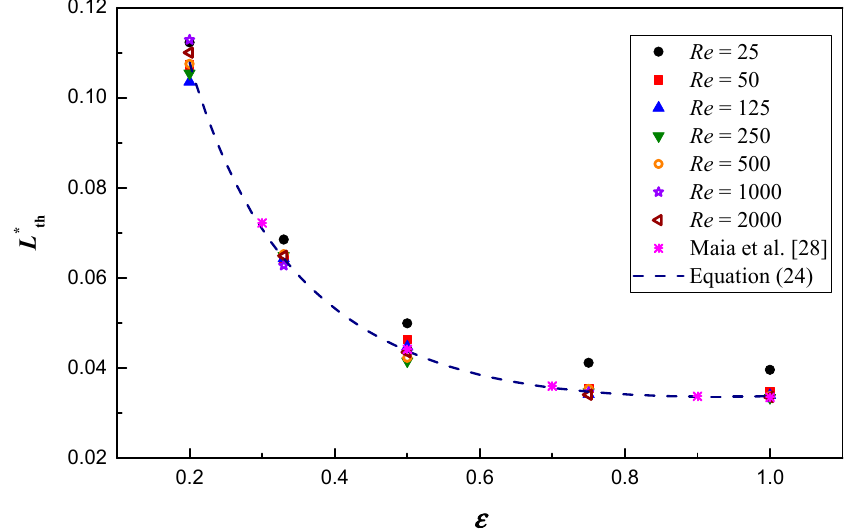
Figure 8. Dimensionless thermal entry length variation along the aspect ratio under di ff erent Reynolds numbers.